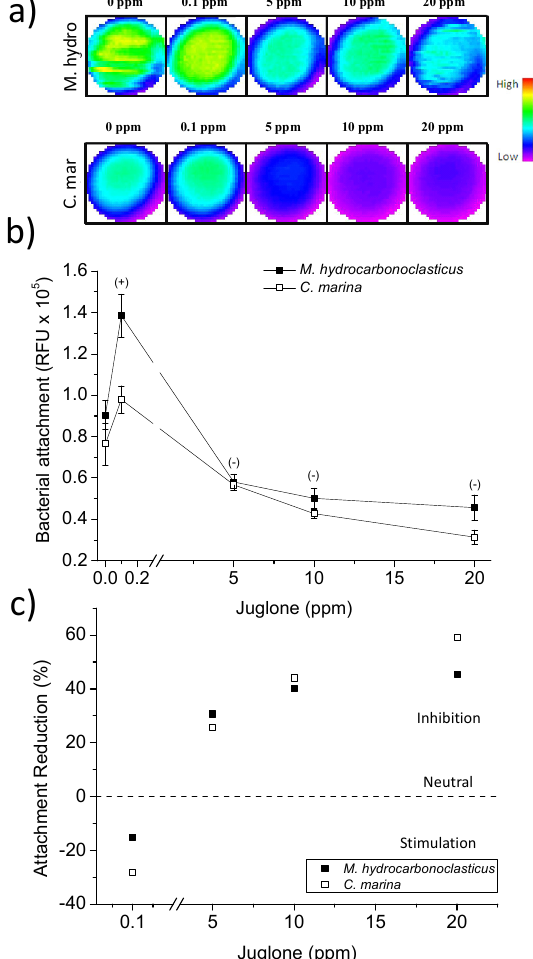
Figure 7. The effect of juglone on C. marina and M. hydrocarbonoclasticus attachment where: ( a ) is the well scan images of individual wells (scan matrix dimension: 30 × 30, equivalent to a resolution of 213 μ m × 213 μ m, scan width 6 mm); ( b ) End point fluorescence intensity (units: relative fluorescent units, RFU). Positive/negative (+/ − ) symbols indicate a significant increase (+) or decrease ( − ) in the attachment of the species when compared with the control at 95% confidence intervals. Syto9: excitation λ = 485 nm, emission λ = 510 nm. Error bars ±STDEV; ( c ) Attachment reduction according to RFU values, as a percentage of the control (0%, dashed line), where negative values indicate increased attachment and positive values,